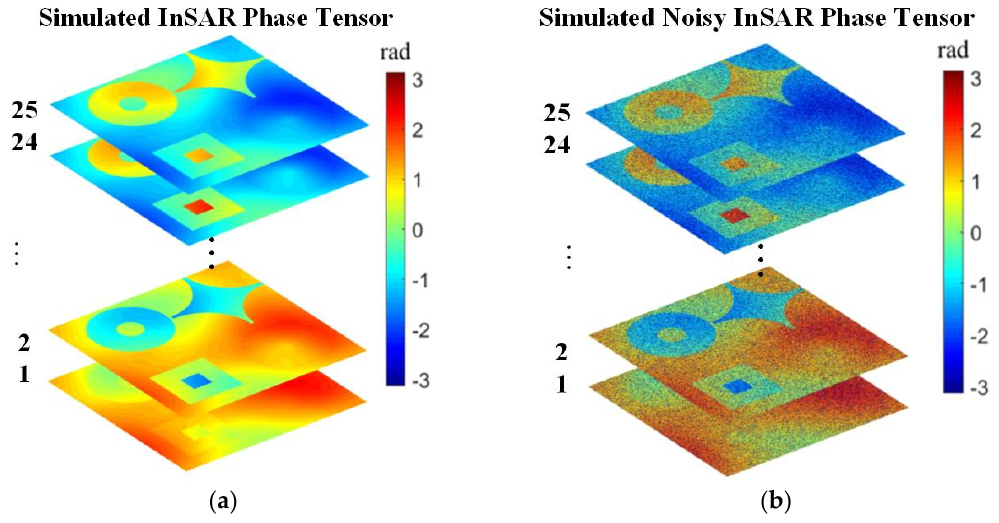
Figure 4. Illustration of the simulated InSAR phase tensor (partly show). ( a ) The interferograms in stimulated noise-free phase tensor; ( b ) the interferograms in stimulated noisy phase tensor. In consideration of the phase that is wrapped between - and , the real and the imaginary part of the InSAR tensor needs to be processed, respectively. As the phase outliers are - or , the outliers can be understood as the pixels missing the actual value. The outliers are caused by the influence of both real and imaginary part. The complex Gaussian noise is diffused in the real and imaginary part. Therefore, the tensor decomposition model is shown as (8).